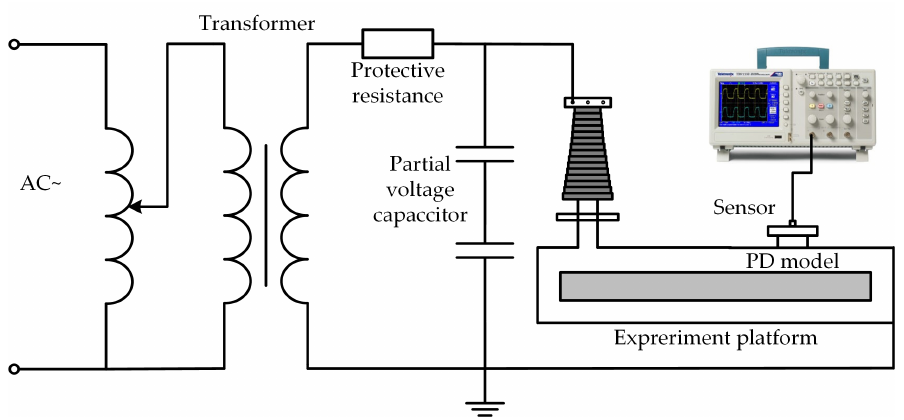
Figure 3. Partial discharge experiment circuit.